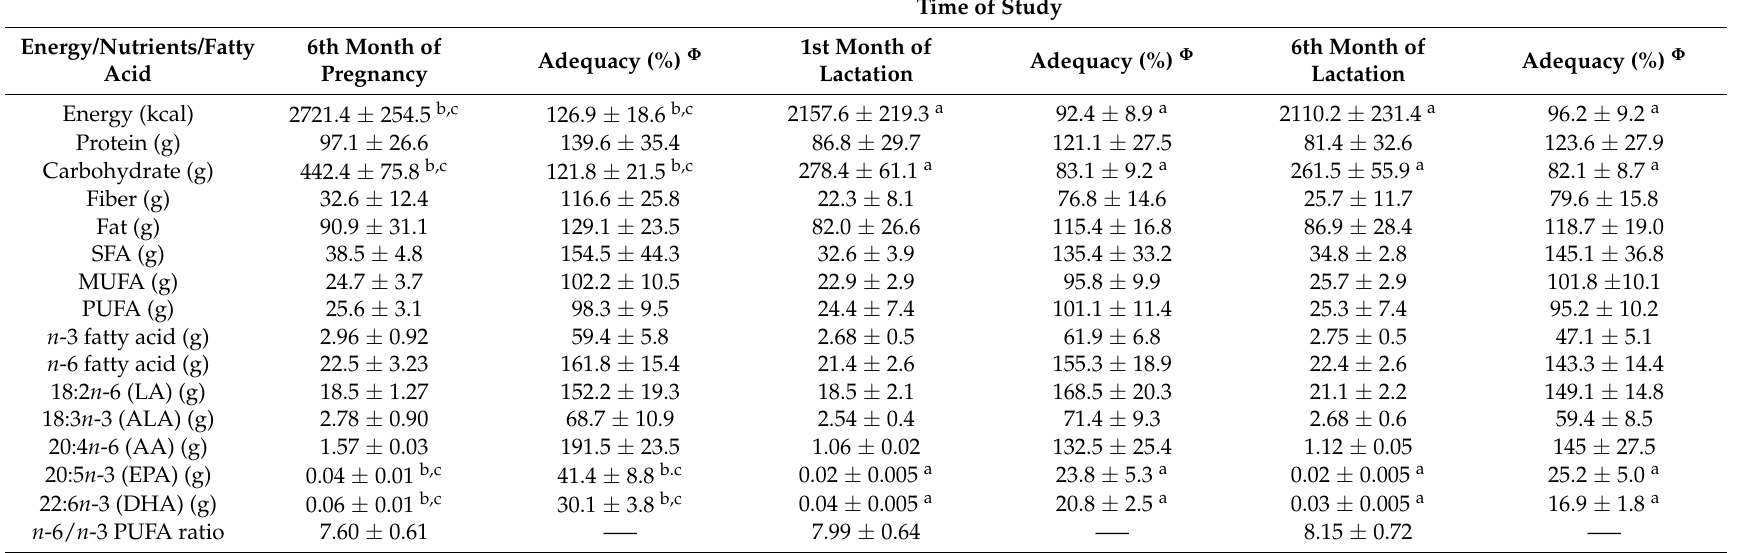
Table 4. Energy, nutrients, and most relevant fatty acid consumed by the women during the pregnancy and lactation period. Time of